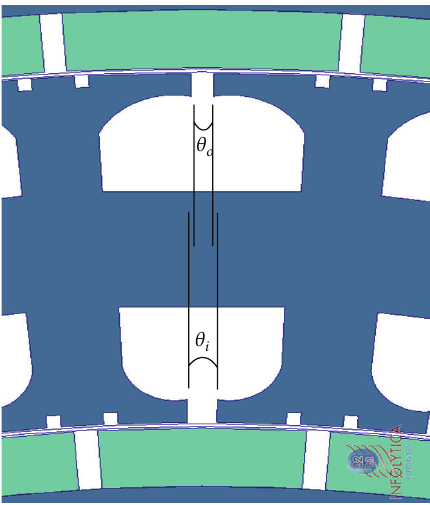
Figure 5: Section of FEA model showing change in slot opening width.